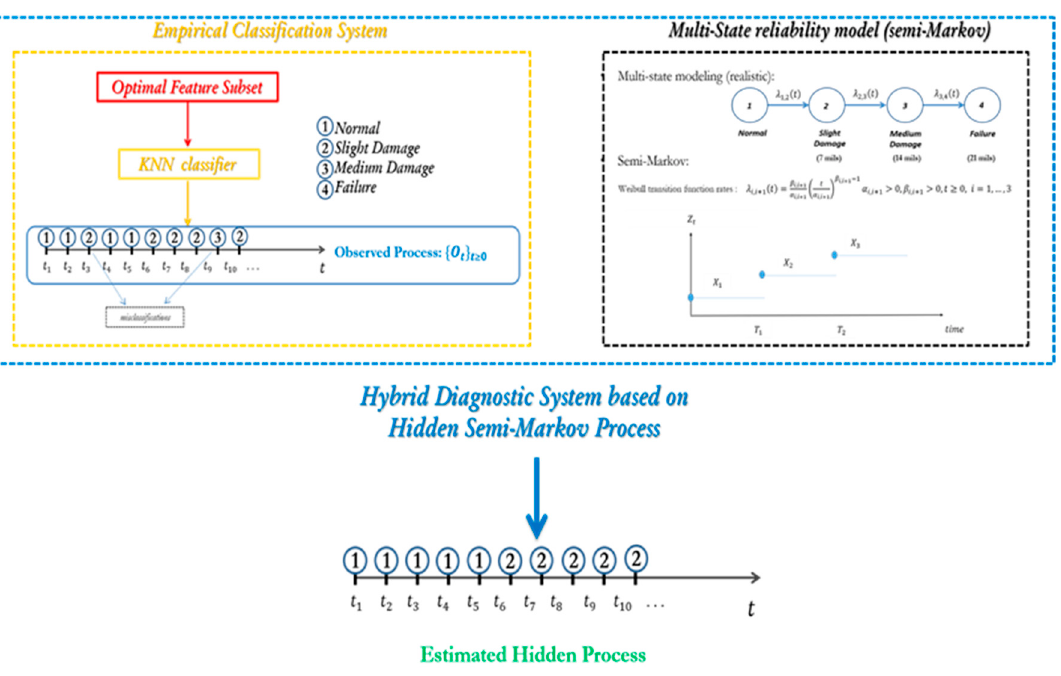
Figure 1. The hybrid diagnostic system based on homogeneous continuous-time finite-state hidden semi-Markov (HCTFSHSMM). In particular, we set the entries of the observation matrix B as the estimated misclassification probabilities of the KNN classification algorithm.